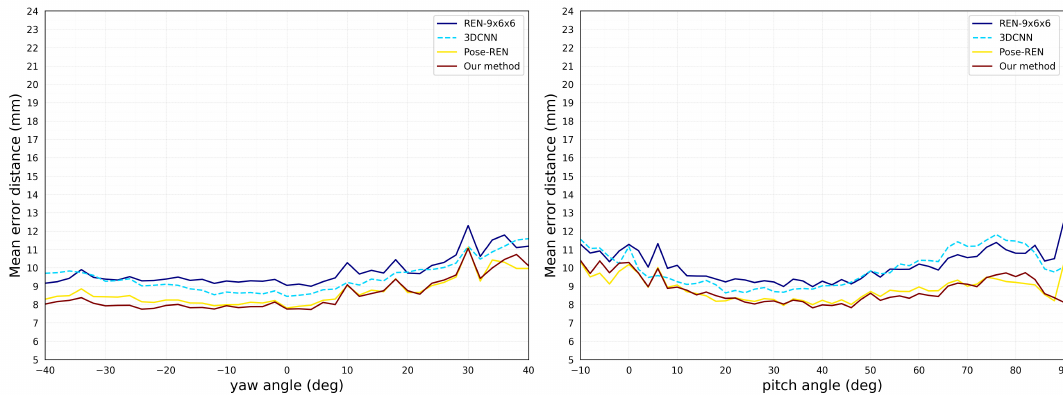
Figure 4. Comparison of mean error distance over different yaw ( left ) and pitch ( right ) viewpoint angles on MSRA dataset. (Best viewed on